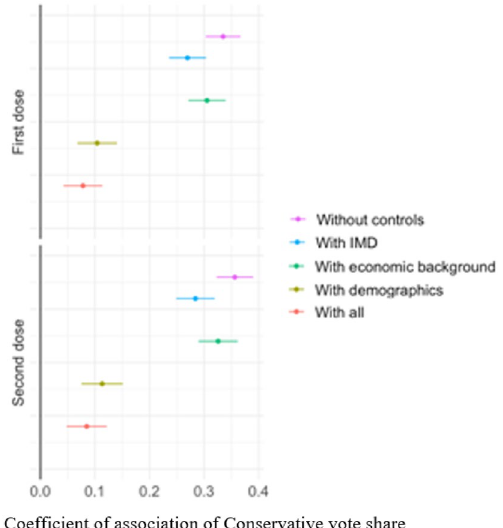
Figure 2. Vaccination and conservative vote share. This figure shows the correlation between the Conservative share of votes and vaccination rates across constituencies. Each circle captures the coefficient of association of Conservative vote share, with the bar on either side showing 95% confidence intervals. The association is statistically significant when the confidence interval does not overlap with the 0-line represented by the vertical axis. The x-axis shows the size of the effect of a one percentage point increase in Conservative vote share on a percentage point increase in vaccination rate. Different colours capture whether the results are based on regressions, without or with a different set of controls. The regression without any controls has a sample size of 532 observations. Once all controls are included, this shrinks to 463 observations. For full results and robustness checks, please see Section S1 in supplementary